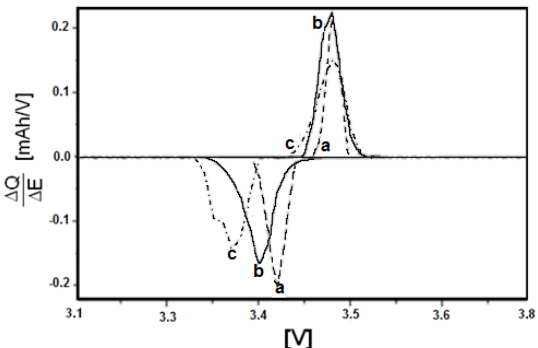
Figure 12. Potential spectroscopy of: ( a ) LiMn 0.1 Fe 0.9 PO 4 ; ( b ) LiMn 0.05 Fe 0.95 PO 4 ; and ( c ) LiFePO 4 .